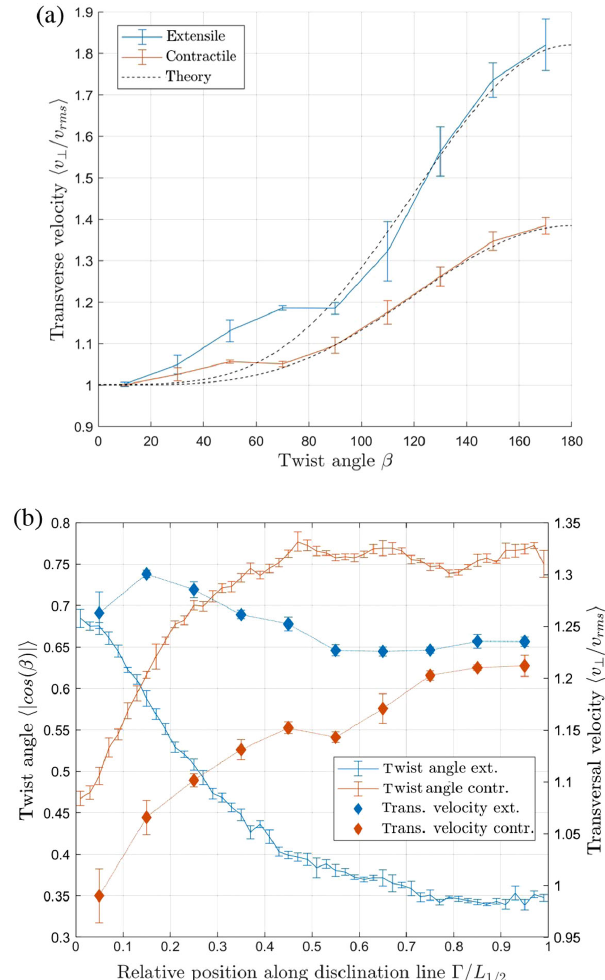
FIG. 8. (a) Mean transverse velocity h v ⊥ i of disclination line segments as a function of local twist angle β . The transverse velocity is normalized by the average root-mean-square velocity v of the fluid. The fit is to the theoretical prediction [13], rms Eq. (13), with the constant of proportionality obtained from a least-square fit. (b) Mean twist angle hj cos ð β Þji and mean transverse velocity h v ⊥ i as a function of the relative position along disclination lines, where values 0 and 1 denote positions close to the surface and in the bulk, respectively. The relative position is measured as the ratio of Γ , which is the path length between each point and the nearest end point of the disclination line, and L 1 = 2 , which is half the total line length. Averaging performed over T ¼ 250 000 time